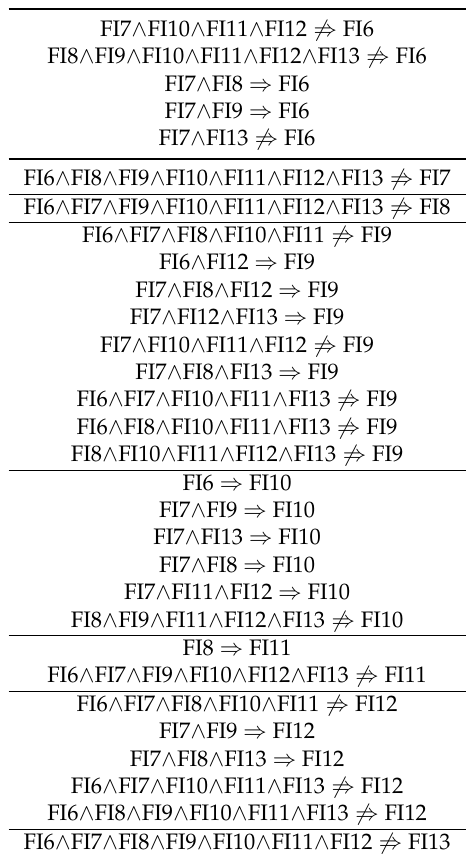
Table 2. Summary of the interrelationships among the eight